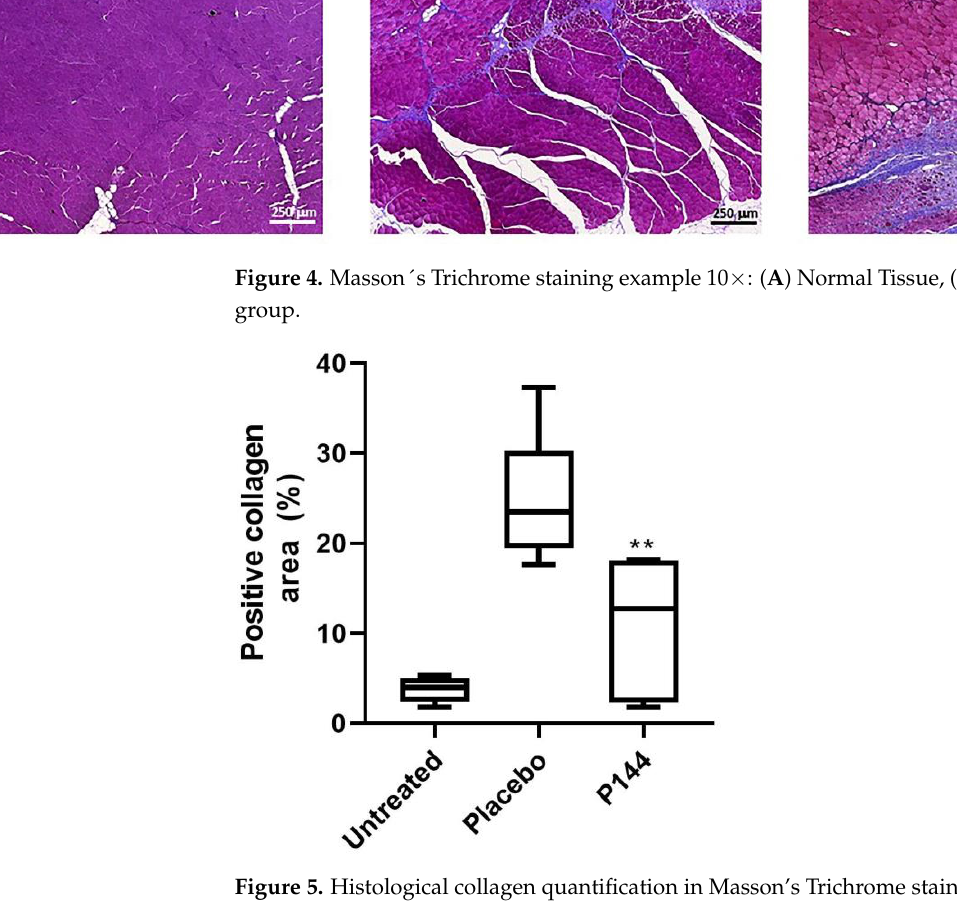
Figure 5. Histological collagen quantification in Masson’s Trichrome stained slides in rabbits muscle tissue that underwent brachytherapy. Untreated, Placebo and P144 treated animals´ collagen tissue content. Statistical significance ** p < 0.01 vs. Placebo group.